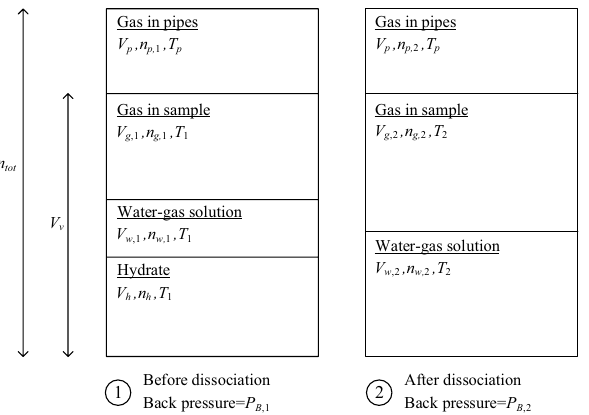
Figure 6. The backpressure system volumes, before and after the undrained dissociation.